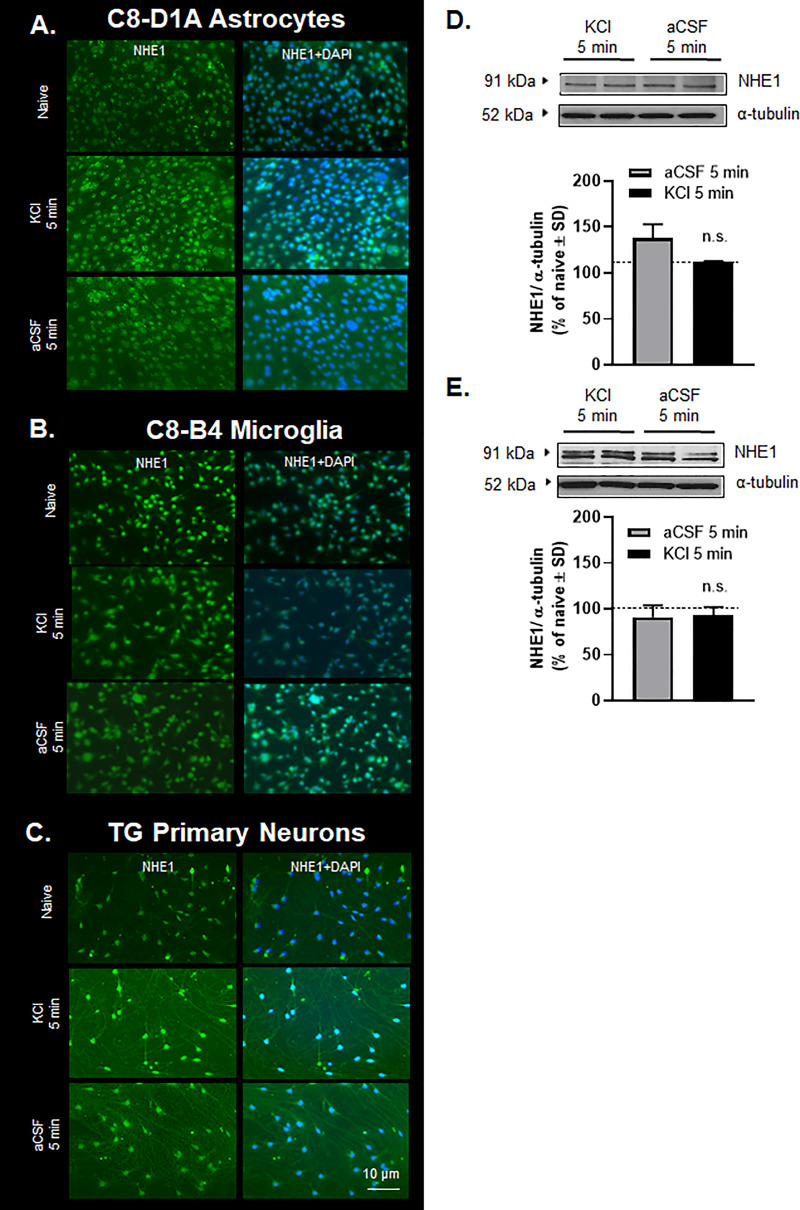
No significant differences were observed in the localization or the total expression of NHE1 in astrocytes (C8-D1A), microglia (C8-B4), and primary culture of TG ganglion.(A-C) Representative immunofluorescence images of astrocytes (C8-D1A), microglia (C8-B4), and primary culture of TG ganglion. (D) Representative immunoblots indicating NHE1 and α-tubulin as a loading control in the whole cell lysate of astrocytes. Values represent the % of naive relative expression ± SD (n = 2). (E) Representative immunoblots indicating NHE1 and α-tubulin as a loading control in the whole cell lysate of microglia. Values represent the % of naive relative expression ± SD (n = 2). The dashed line indicates the relative expression of NHE1 in naïve samples. n.s. = non-significant.